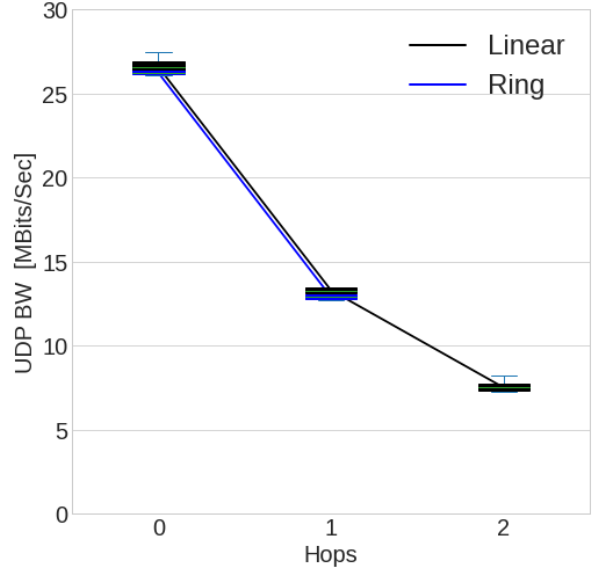
Figure 29. CityLab UDP bandwidth.